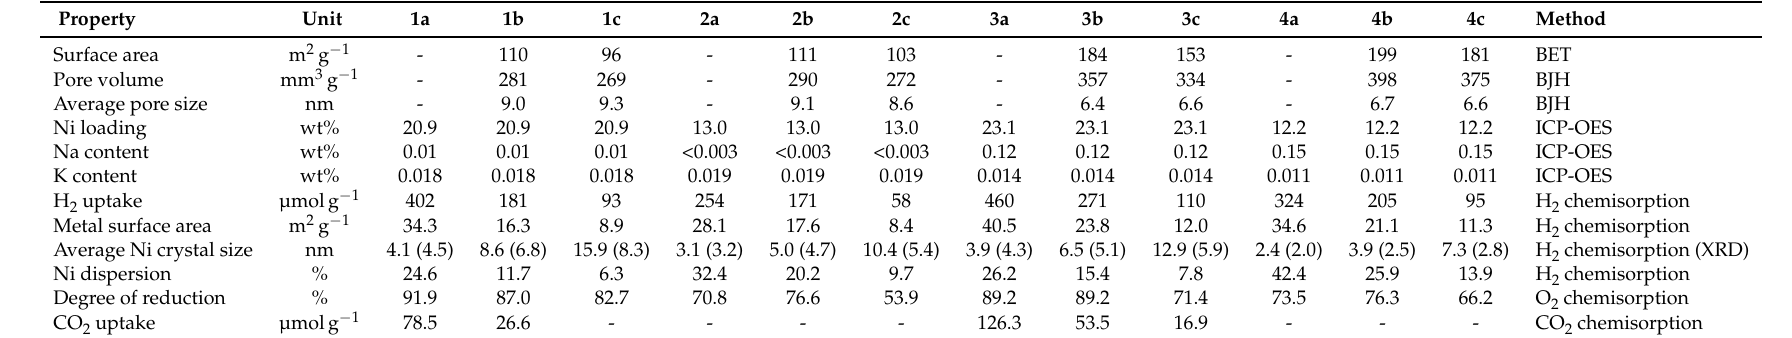
Table 1. Summary of the characterization results for all Ni/SiO 2 catalysts. The naming convention applied in this work is provided in Figure 1. The samples that were not calcined (1a, 2a, 3a, 4a) loose mass during the reduction because of the decomposition of remaining nitrates. This mass loss was measured with a thermogravimetric analysis (see Table S1) and accounted for in the evaluation.